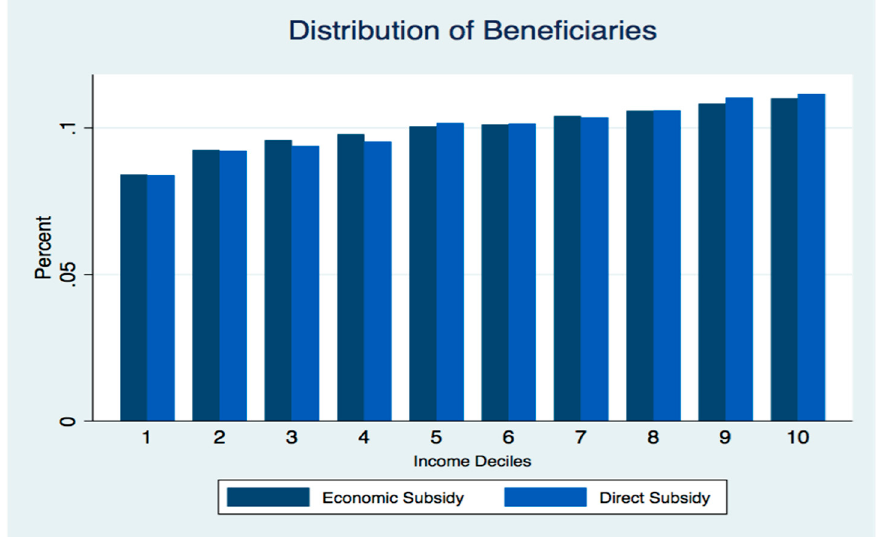
Figure 9. Distribution of subsidy beneficiaries by income decile, 2014. Source: own calculations with data from ENIGH [25]; and PIGOO